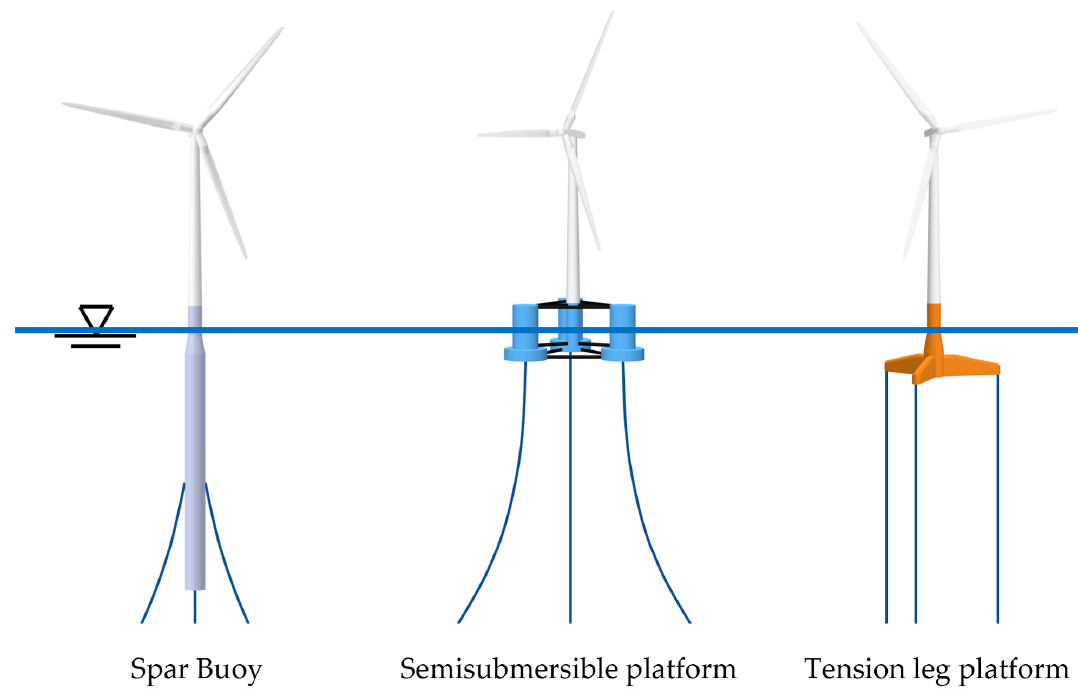
Figure 1. FWT mooring